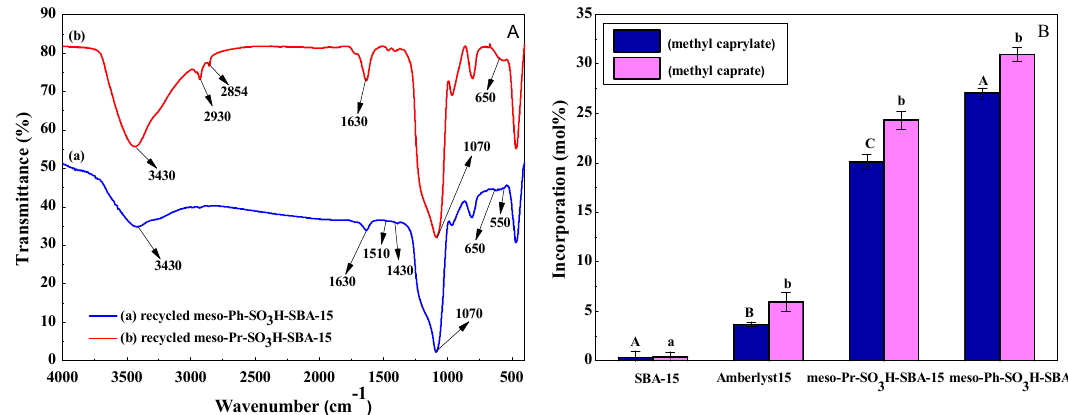
Figure 8. ( A ) FT-IR spectra of two recycled modified SBA-15 samples. ( B ) Comparison of catalytic performances of two modified SBA-15 samples with commercial Amberlyst-15. SL: 0.1 g, methyl caprate (or caprylate): 1.45 g (or 1.20 g), catalyst: 0.078 g for methyl caprate or 0.065 g for methyl caprylate, hexane: 5 mL, 40 °C, 6 h. Values of different groups with different upper ‐ case or lower ‐ case letters are significantly different at p < 0.05.